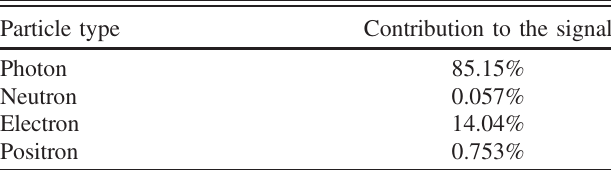
TABLE III. Contributions from the different secondary par- ticles to the signal for the controlled beam loss experiment with a movable emittance monitor.